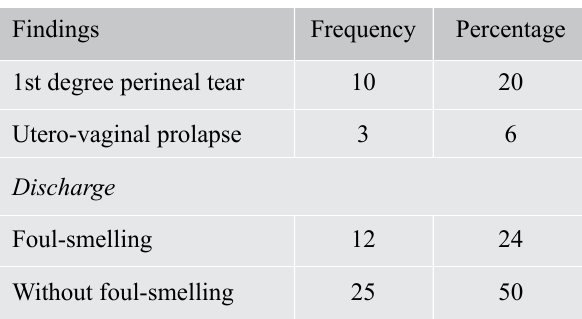
Table II: Findings on inspection of external